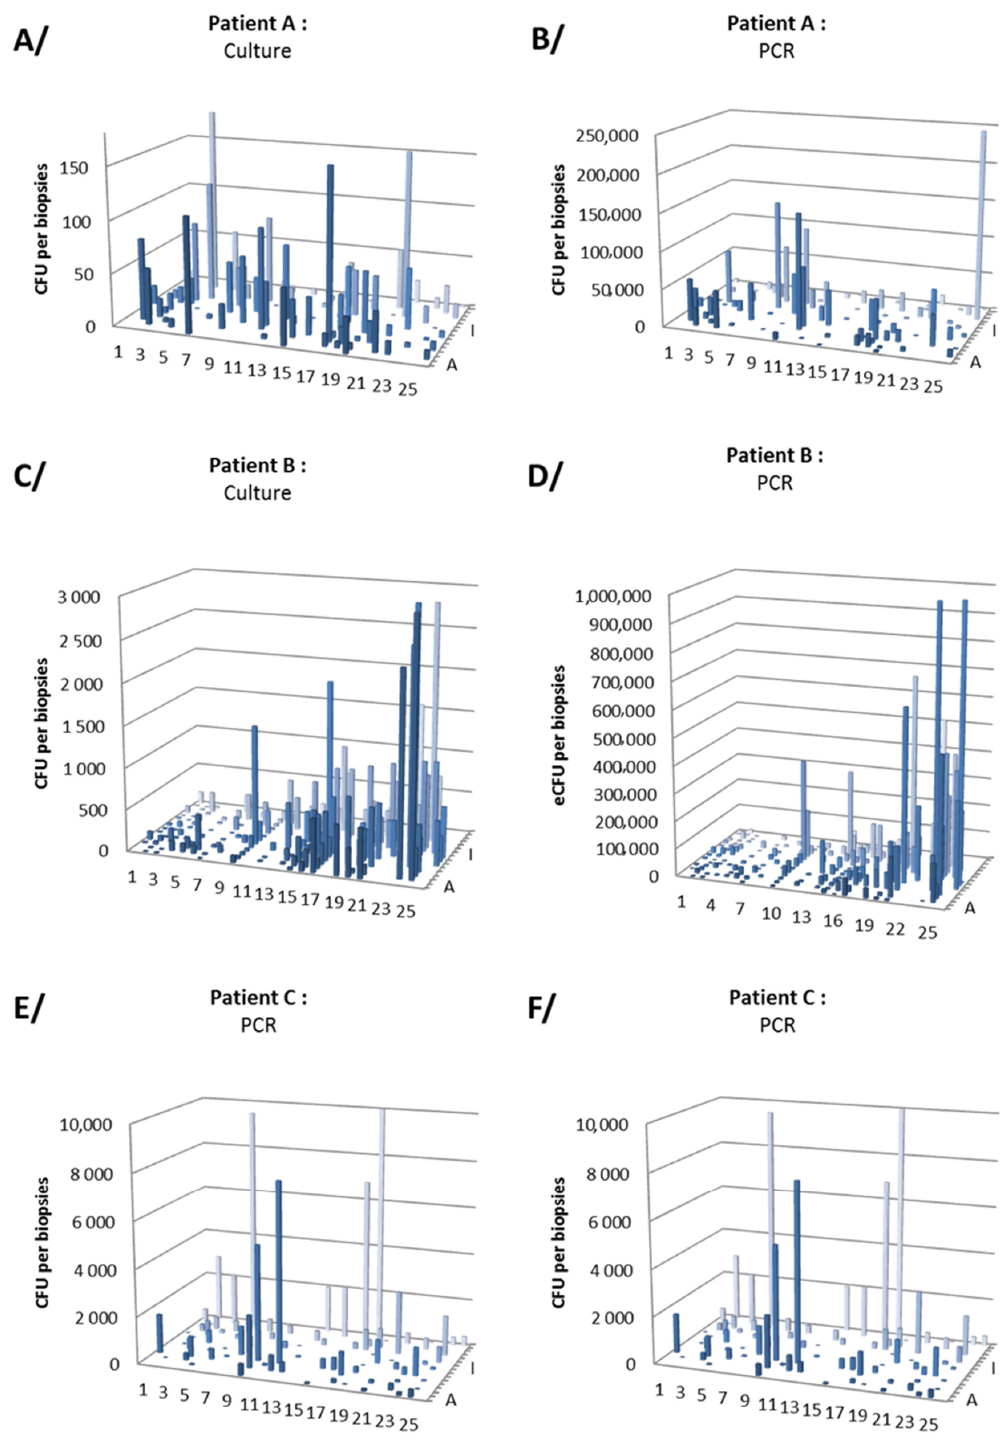
Figure 1. Quantitative distribution of Helicobacter pylori in the stomach of three patients. ( A , B ) correspond to patient A; ( C , D ) to patient B; ( E , F ) to patient C. ( A , C , E ) correspond to bacterial quantification using culture method in CFU/biopsy and ( B , D , F ) to qPCR method in eCFU/biopsy. Colors are only meant to clarify the visualization of the charts.